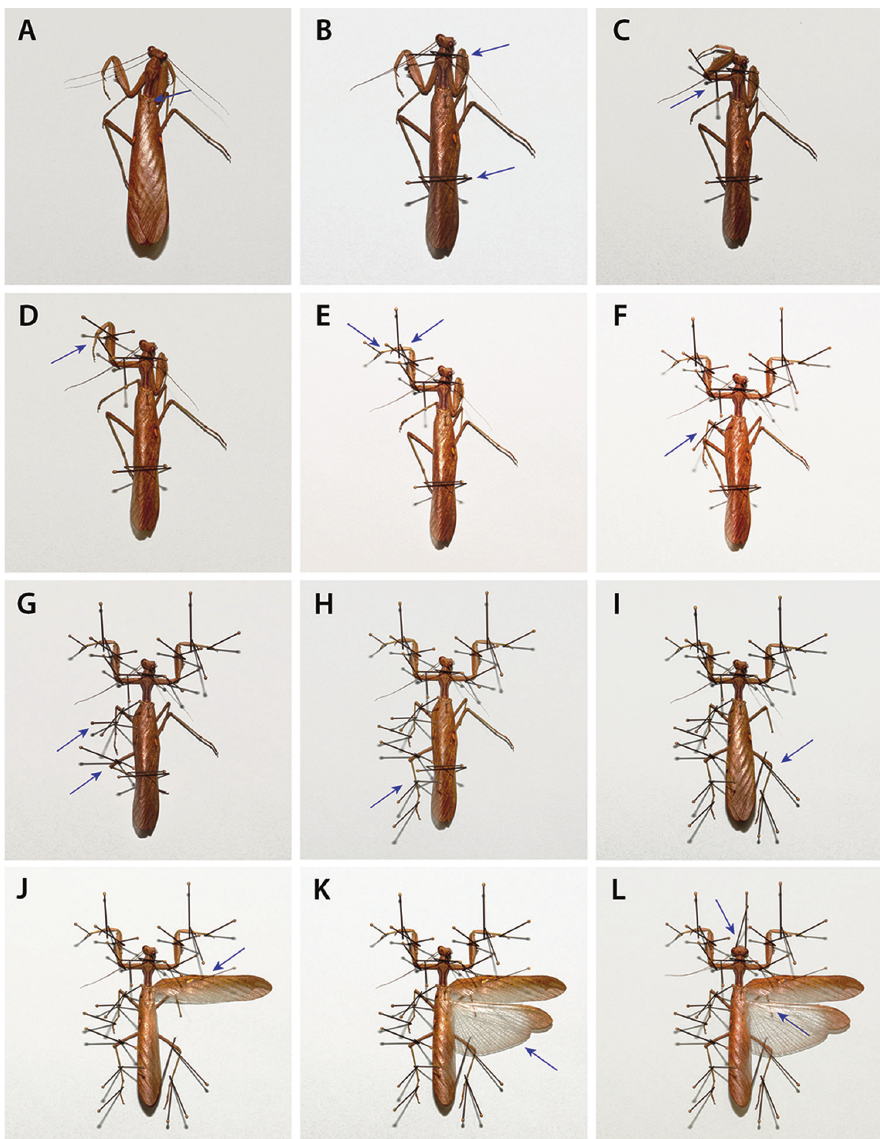
Figure 23. Pinning demonstration of a relaxed Sphodromantis sp. specimen. Blue arrows indicate approximate locations to arrange and/or pin specimen. A Pin specimen to the right of the midline in the mesothorax, just above the forewings B insert pins across the prozone and abdomen to support the specimen while pinning C position and secure the forecoxae D position and secure the forefemora E position and secure the foretibiae and foretarsi F – I position and secure the left mid- and hindleg as well as the right hindleg; the right midleg needs to be arranged but not secured with pins to accommodate the wings (see J ) J position and secure the right forewing K position and secure the right hindwing L if needed, make further adjustments to the position of the head, antennae, and right mesothoracic leg to ensure bilateral symmetry. Due to the morphological diversity of pray- ing mantises, some modifications to this method might need to be employed to minimize specimen